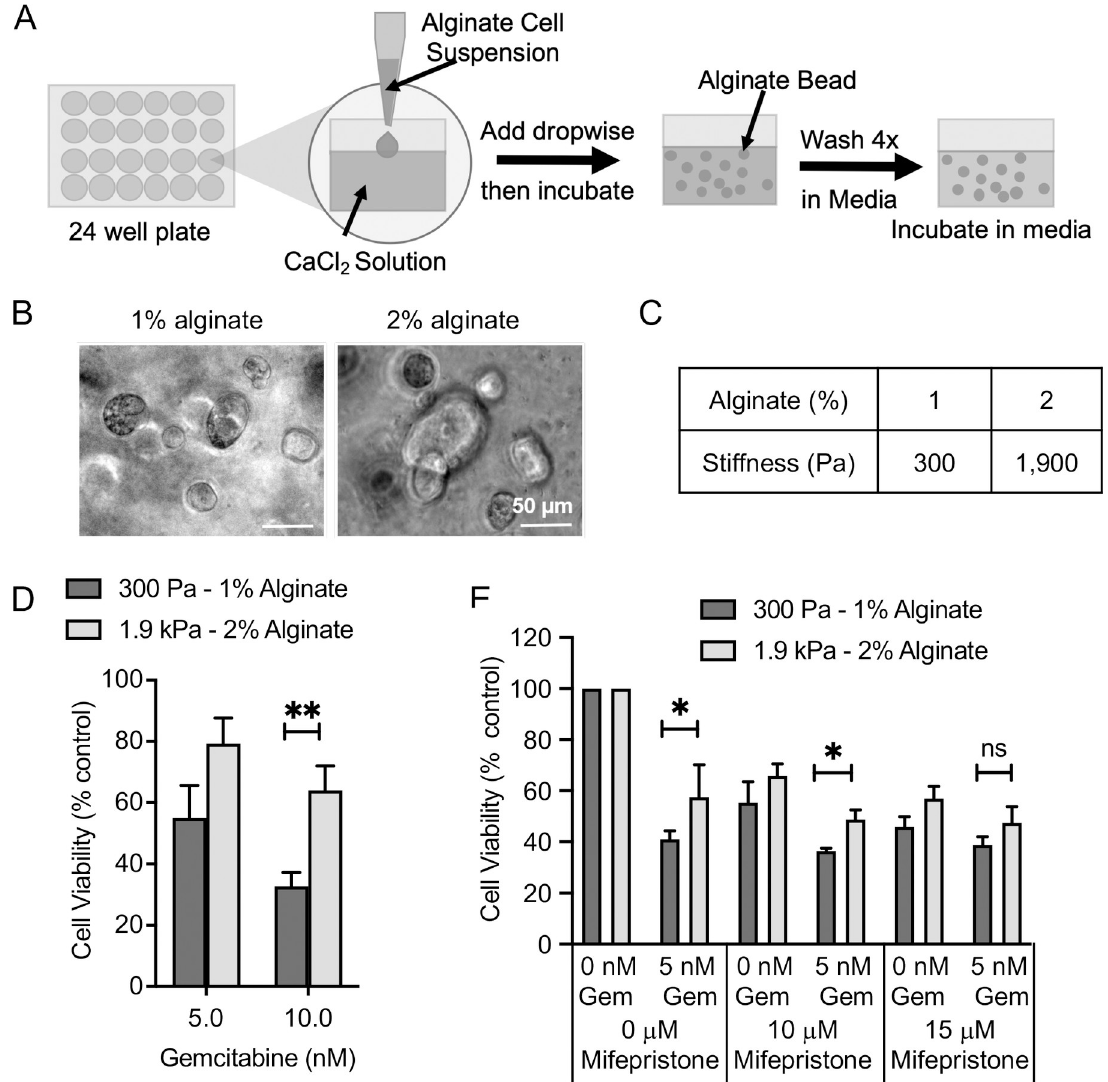
Fig 6. Resistance to gemcitabine at higher stiffnesses also occurs in a 3D model and is reversed by mifepristone. (A) Schematic of the alginate model where different alginate percentages are used to give different stiffnesses. Beads were formed by dropping alginate cell suspension into calcium chloride solution. Alginate beads were then washed in medium and cells allowed to grow by incubating at 37˚C. (B) Representative brightfield images of MCF-7 cells 96 hrs post alginate bead gelation. (C) Rounded average measured elastic modulus measured for 6 gels pooled from 2 independent repeats measured 1 hr after gelation at a frequency of 1 Hz by rheometry. (D) MCF-7 cells were cultured in alginate beads for 24 hrs prior to the addition of gemcitabine, after 72 hrs treatment cell viability was measured by alamarBlue assay. The means and SEMs are plotted for 4 independent repeats. (E) MCF-7 cells were cultured in alginate hydrogels for 24 hrs prior to the addition of mifepristone. After 24 hrs 5 nM gemcitabine (Gem) was added. Cells were incubated for 72 hrs before cell viability was measured by alamarBlue assay. The means and SEMs are plotted for 3 independent repeats. Significance was calculated using a Student’s paired